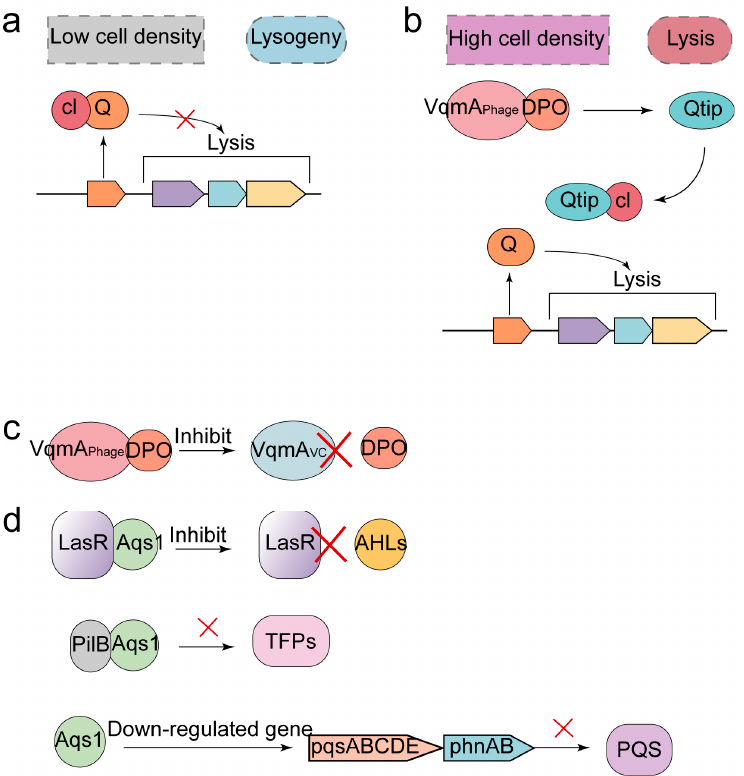
Figure 7. The hindering effect of phages on the QS system. ( a ) Under the low cell density conditions, the cI repressor binds to the Q promoter and inhibits the expression of phage lysis genes. ( b ) Under the high cell density conditions, Qtip recognizes and binds cI, thus inhibiting the binding of cI to the Q promoter and allowing the phages to enter the lysis cycle. The VqmA Vc produced by Vibriophage VP882 is able to activate the expression of Qtip (Gp55) by binding to 3,5-dimethylpyrazin-2-ol (DPO). ( c ) Phages impede the binding of DPO to VqmA Vc by encoding the receptor VqmA Phage , which can bind to DPO. ( d ) Phages synthesize the protein Aqs1, which resembles AHLs, thereby impeding the binding of AHLs to the QS receptor LasR. In addition, by interacting with PilB, AHLs impede the adsorption of phages to P. aeruginosa Aqs1 can downregulate the pqsABCDE and phnAB operons and inhibits the production of the quinolone system (PQS).